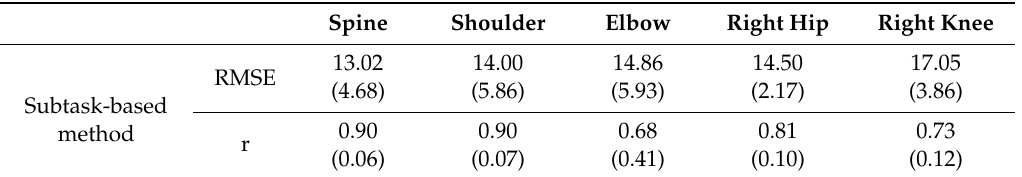
Table 3. Root-mean-square-error (RMSE) and Pearson correlation coefficient (r) averaged across 18 subjects; values are represented as mean (standard deviation).